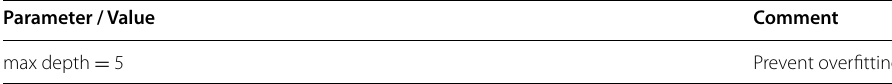
Table 6 Decision Tree classifier